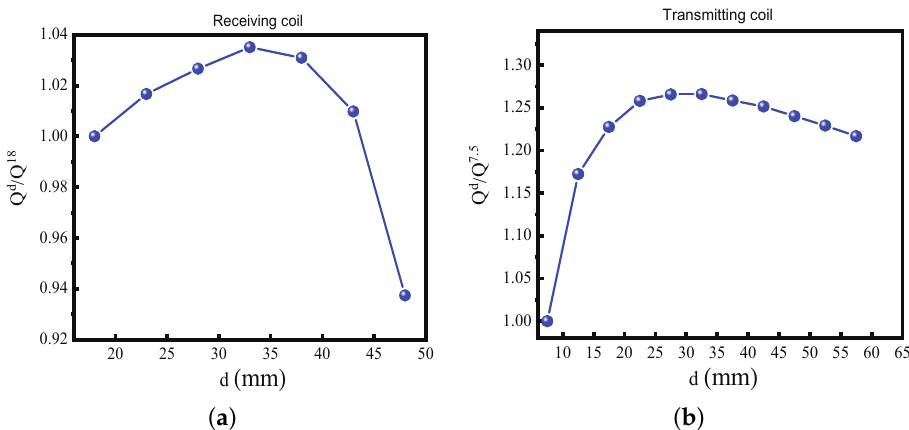
Figure 4. Variation of the normalized quality factor of the coils with the distance d between the coil and the metal structures on both sides. ( a ) Receiving coil. ( b ) Transmitting